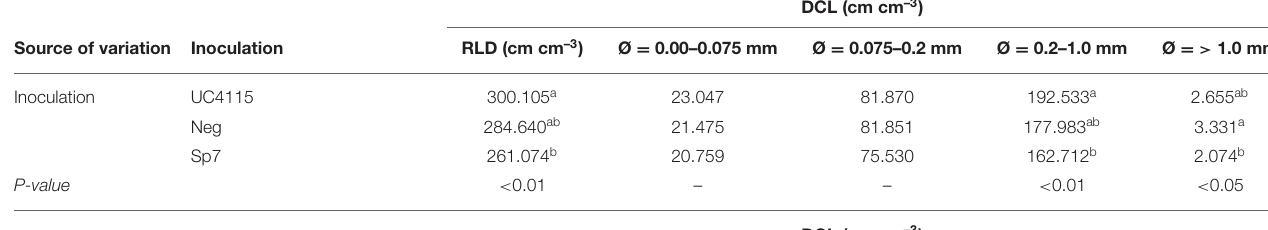
TABLE 4 | Root length density (RLD), and diameter class length (DCL) for very fine (Ø = 0.00–0.075mm), fine (Ø = 0.075–0.2mm), medium (Ø = 0.2–1.0mm), and coarse (Ø = > 1.0mm) diameters for organic experiment, as affected by inoculation (I) and application (A). Source of variation